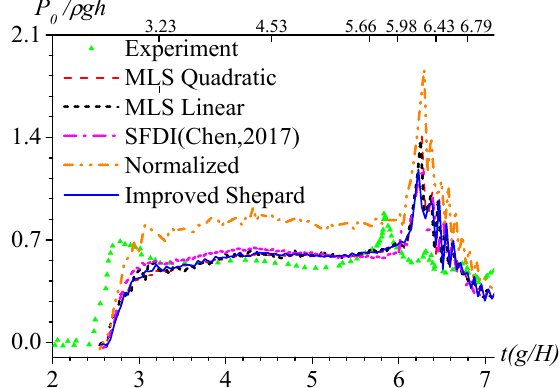
Figure 7. Dam-break flow against a vertical wall. Comparison between the pressure loads measured experimentally and predicted by the numerical model at P 1 .